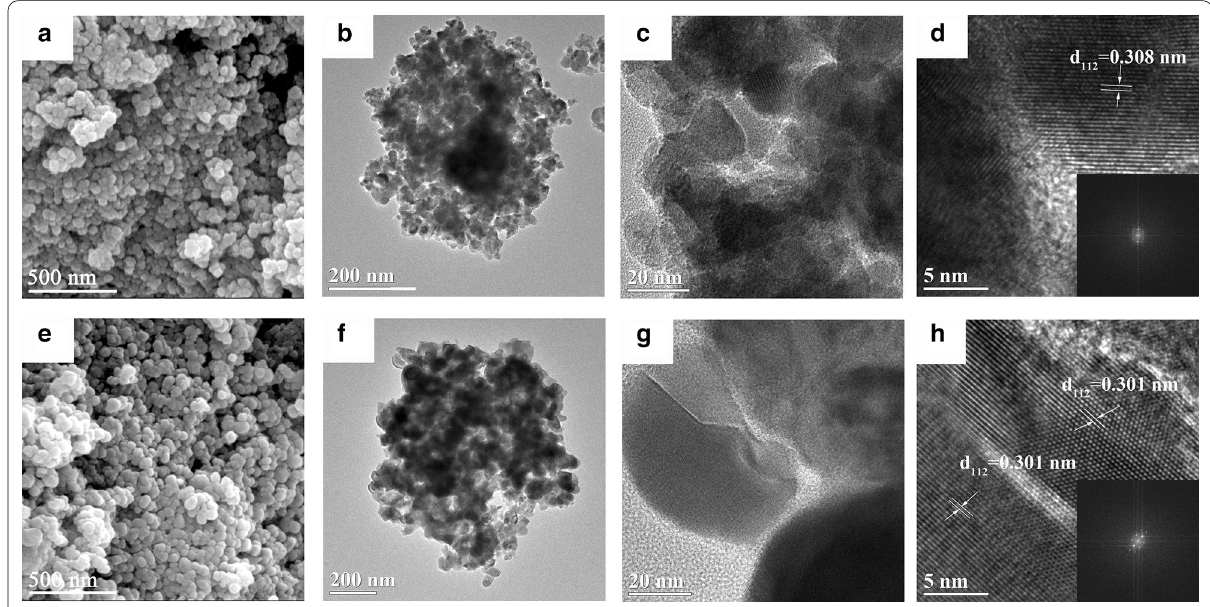
Fig. 2 a SEM, b , c TEM, and d HRTEM images of as-prepared Cu 2 SnS 3 nanoparticles; e SEM, f , g TEM, and h HRTEM images of annealed Cu 2 SnS 3